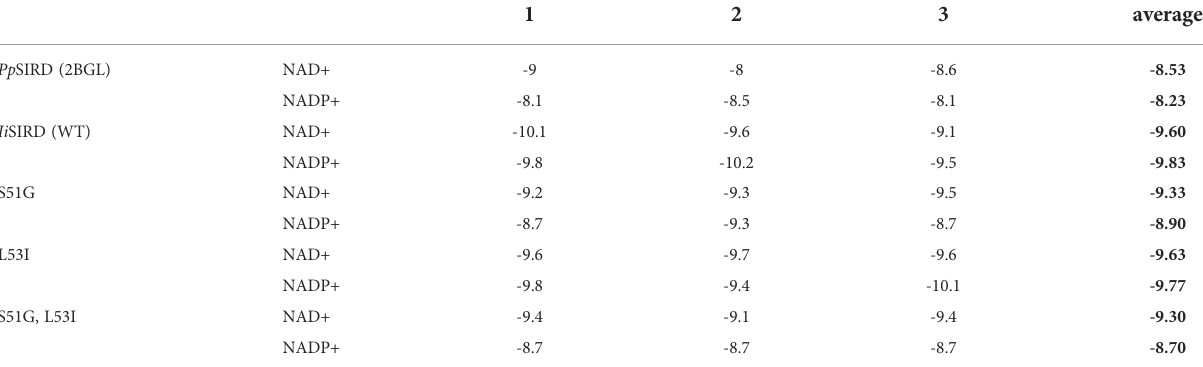
TABLE 2 Molecular docking results (Average values calculated from triplicate results were highlighted in bold).